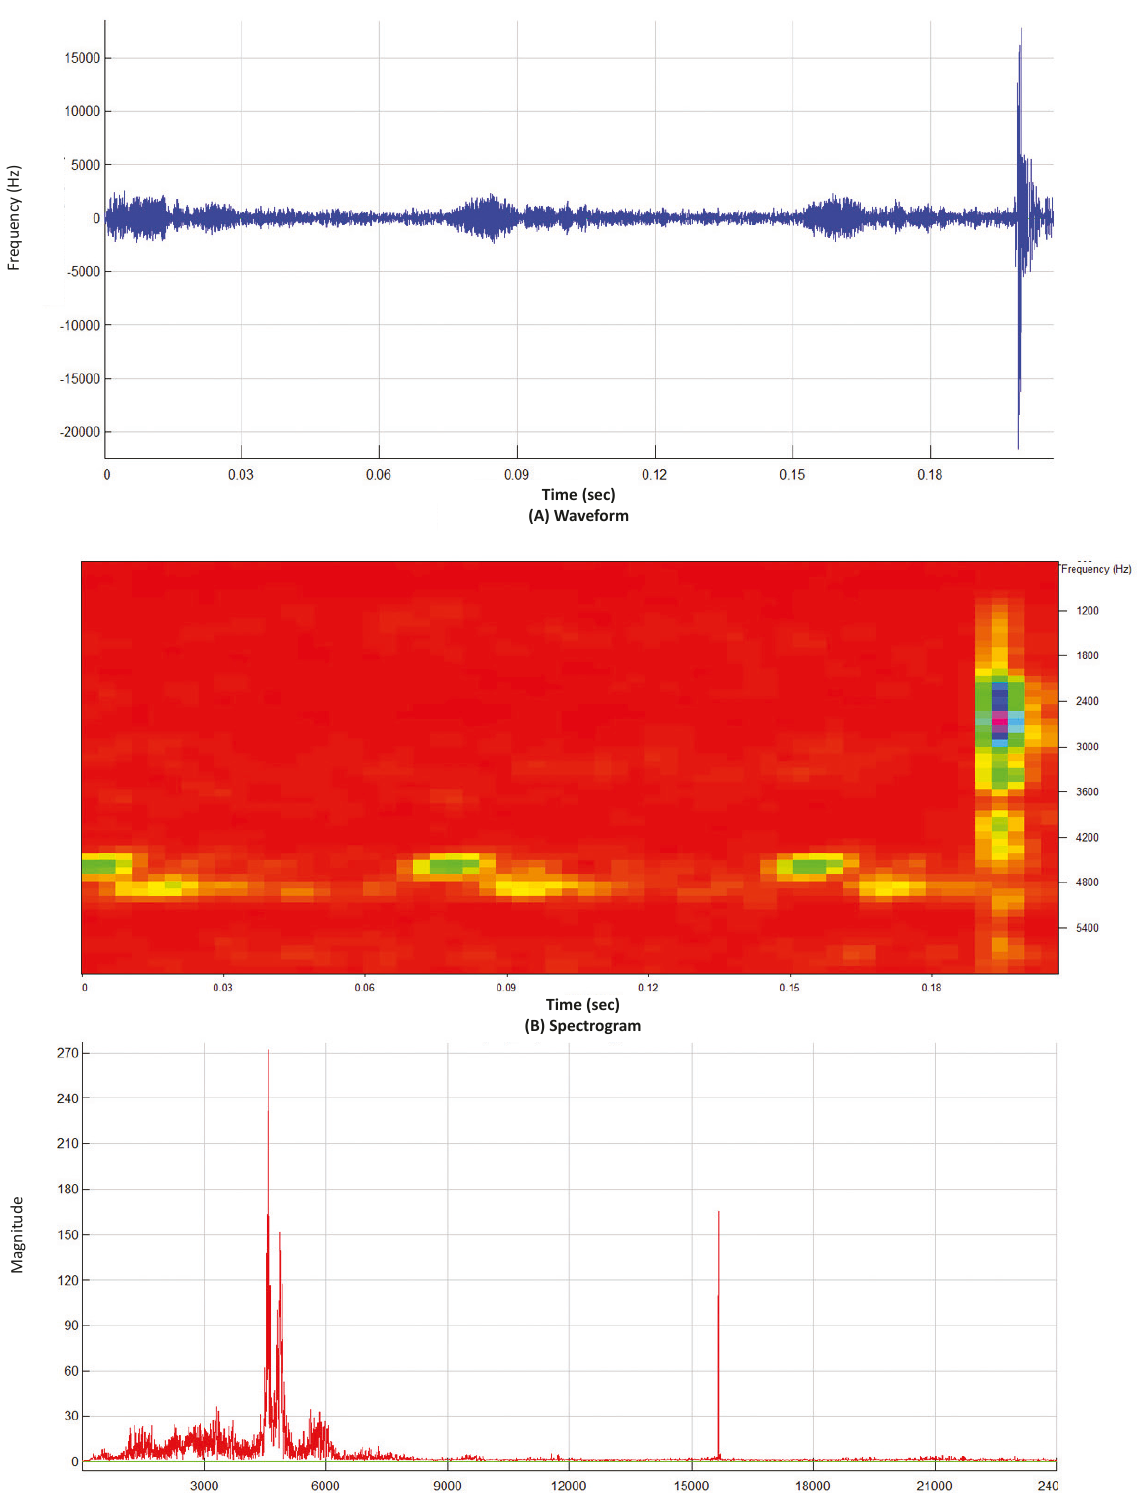
Figure 1. Type II advertisement call in R. lateralis . A - Waveform, B - Spectrogram and C - Band